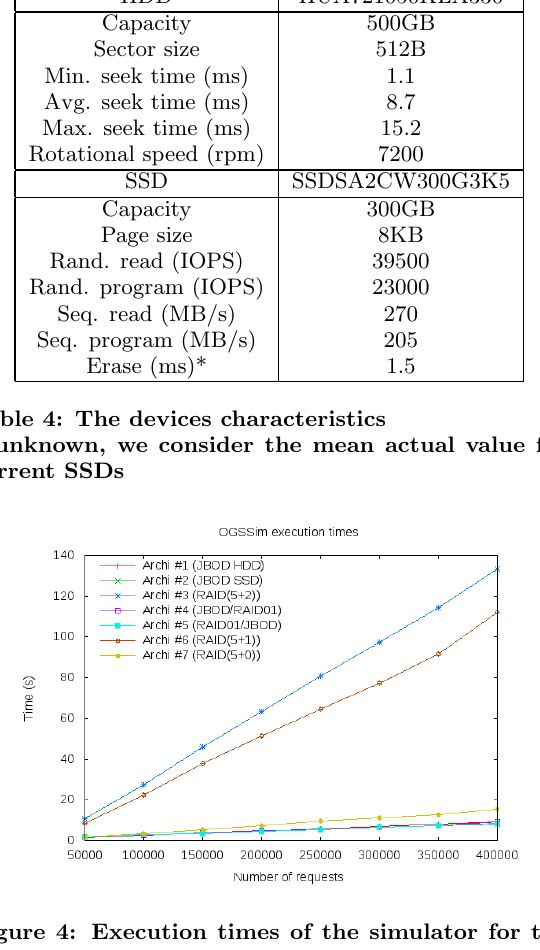
Figure 4: Execution times of the simulator for the S trace 2 have similar simulation duration independently of the archi- tecture configuration.